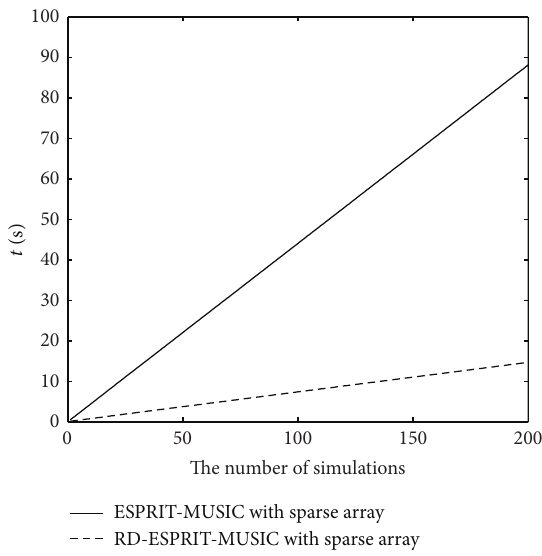
Figure 7: The runtime of algorithms